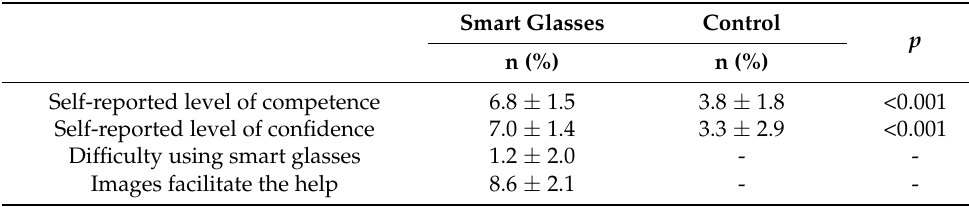
Table 3. Perceptual variables of competence, confidence, difficulty using the smart glasses, and image